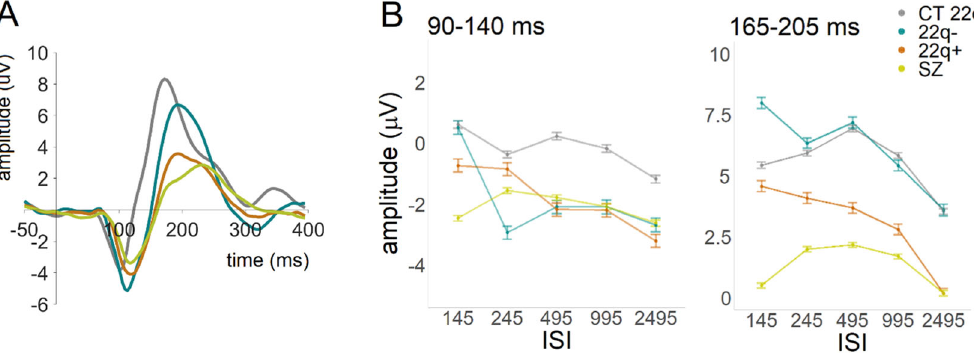
Fig. 6 ERPs and adaptation summary per group and ISI. A Averaged ERPs per group (CT 22q, 22q − , 22q + , and SZ) at Oz, showing the average of all ISIs. B Curves representing visual adaptation effects between groups (CT 22q, 22q − , 22q + , and SZ) in the time windows of interest (90 – 140 ms and 165 – 205 ms). Error bars represent standard errors of the